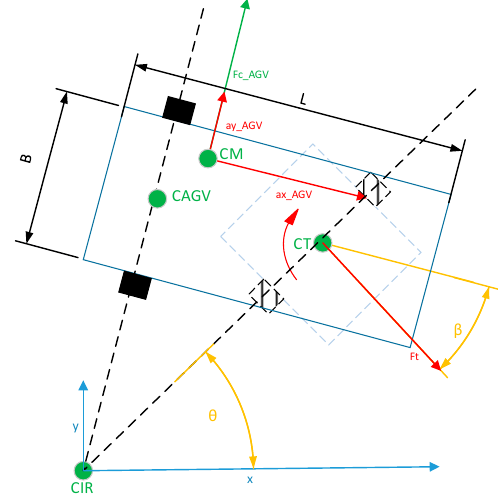
Figure 7. Model of the body of the AGV.